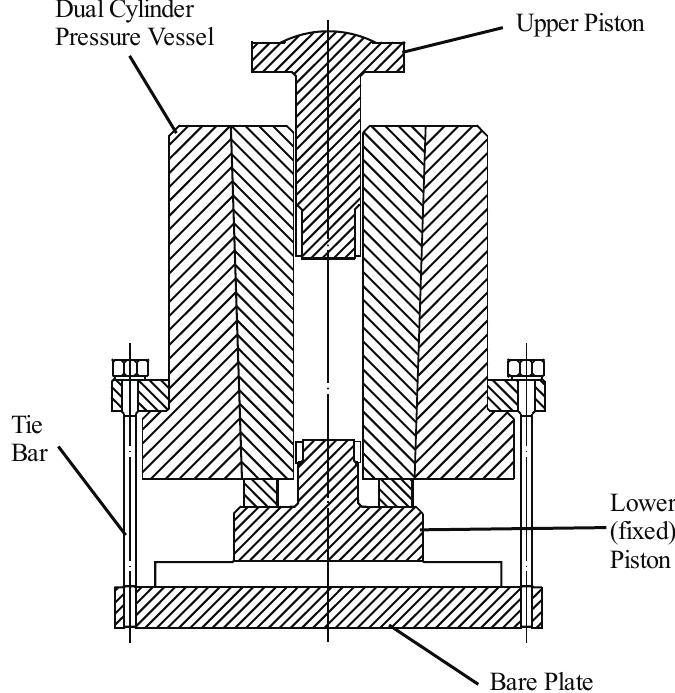
Figure 8. Sketch of the 1.2 GPa oil pressure chamber.